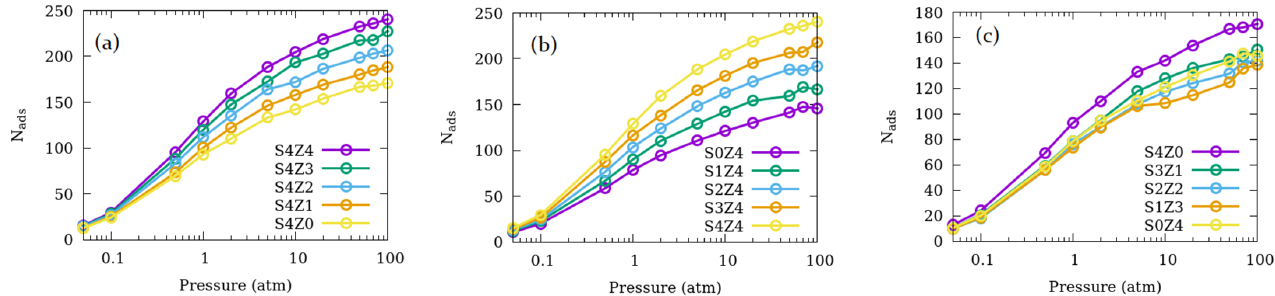
Figure 3. Adsorption isotherms of CO 2 in silicalite from GCMC simulations of ( a ) S-majority, ( b ) Z-majority, and ( c ) half- blocked models as included in Table 1.